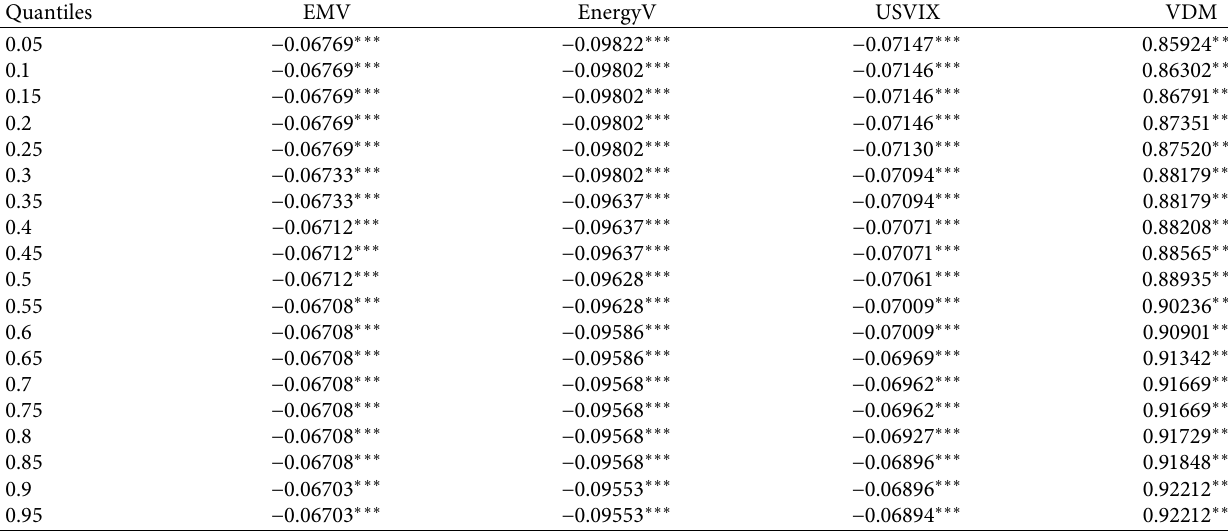
Table 7: Effect of volatilities on DJIMWI.